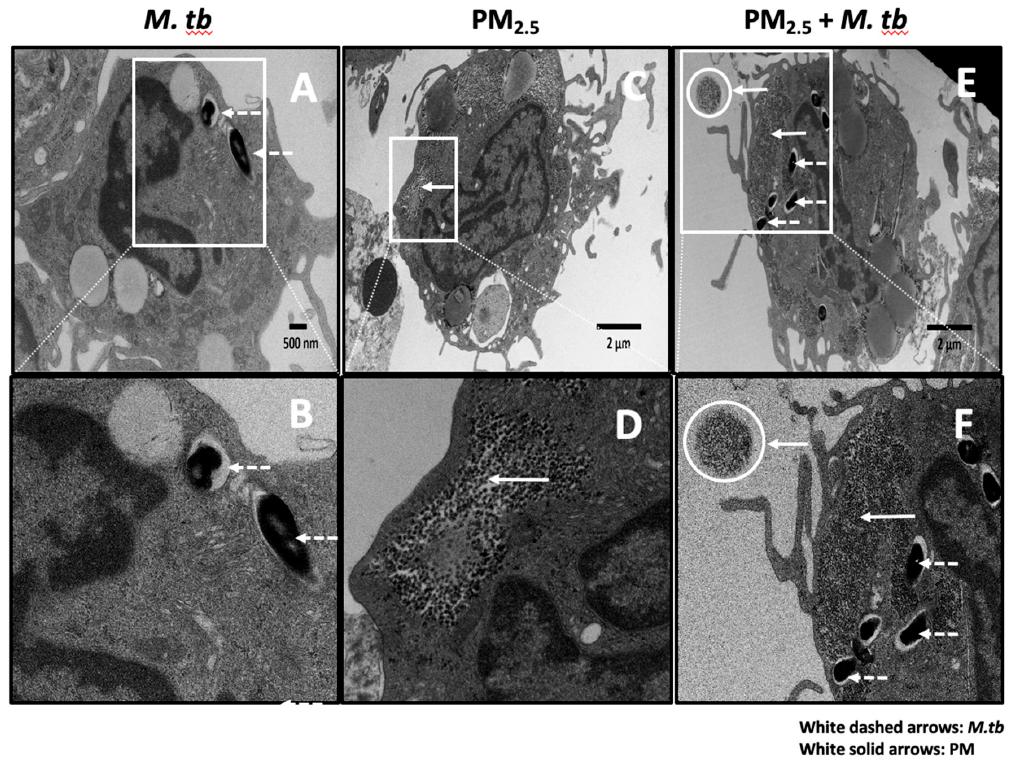
Figure 1. Transmission electron microscopy (TEM) of PM 2.5 and Mycobacterium tuberculosis (M.tb) uptake in human peripheral blood monocytes. ( A , B ) Endocytic vacuoles containing M.tb (white dashed arrows) showing uptake of multiple M.tb by a monocyte. ( C , D ) Monocyte containing air pollution PM 2.5 (after 20 h exposure to 5 µ g / mL PM 2.5 , white solid arrows). ( E , F ) Monocyte showing clusters of PM 2.5 (white solid arrows, after 20 h exposure to 5 µ g / mL PM 2.5 ), and endocytic vacuoles containing M.tb (white dashed arrows, MOI 5) after M.tb infection for an additional 18 h. A free aggregate of PM 2.5 (white circles) is visible extracellularly in panels E and F . Panels B , D , and F are zoomed images of panels A , C , and E respectively.